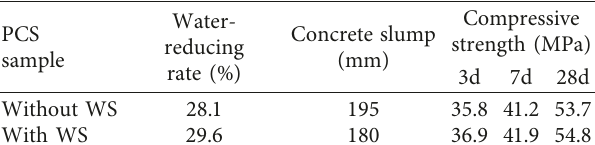
Figure 4: Cement fluidity under different dosages of PCS produced with wheat straw. Table 4: Values of water-reducing rate, concrete slump, and compressive strength of PCS samples produced with and without wheat straw